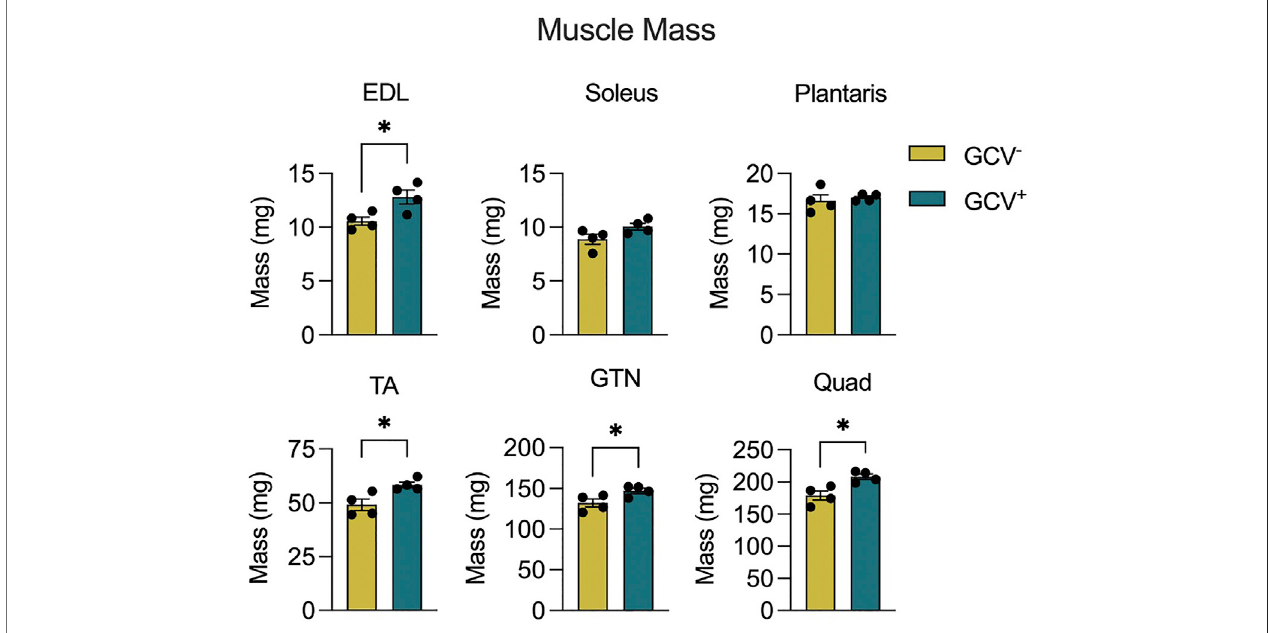
FIGURE 2 | Hind limb muscle masses were preserved in male GCV + mice. Masses are shown for extensor digitorum longus (EDL), tibialis anterior (TA), gastrocnemius (GTN) and quadriceps (Quad) muscles in milligrams for male ganciclovir treated (GCV + ) and vehicle treated (GCV − ) mice. Bars show the mean ± SEM of four mice per group with dots representing data from each individual male mouse. *Denotes p < .05 between groups by two-tailed unpaired t-test.